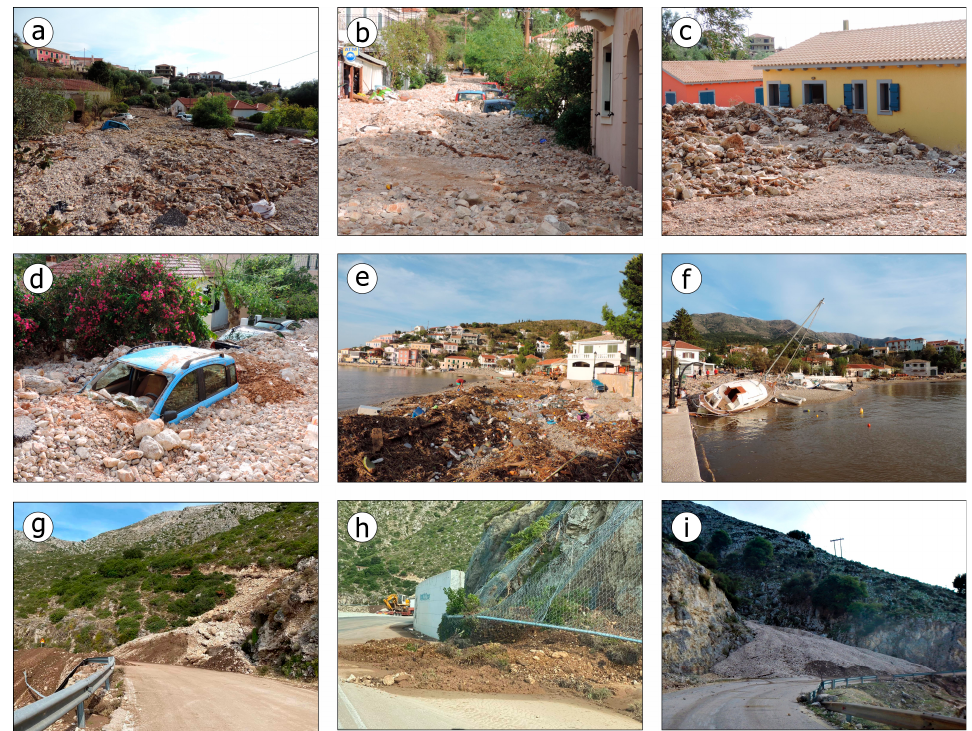
Figure 5. Typical views of the impact of Medicane Ianos on Cephalonia Island: ( a – d ) debris inundated public and private areas of Assos village causing minor non-structural damage to buildings and blockage of ground floor entrances. ( e , f ) The port of Assos village was also affected by the generated debris flows. Debris flooded the coastal road, part of the port, and the adjacent beaches, resulting in morphological changes. ( f – i ) Debris flows were also triggered in several sites in the Agia Efimia area, resulting in temporary traffic disruption due to accumulation of debris on adjacent parts of the road network. Assos is located in the western part of the Erissos peninsula, while Agia Efimia is located in the eastern part of the transition zone from the Erissos peninsula in the north to the Aenos Mt fault block to the south.